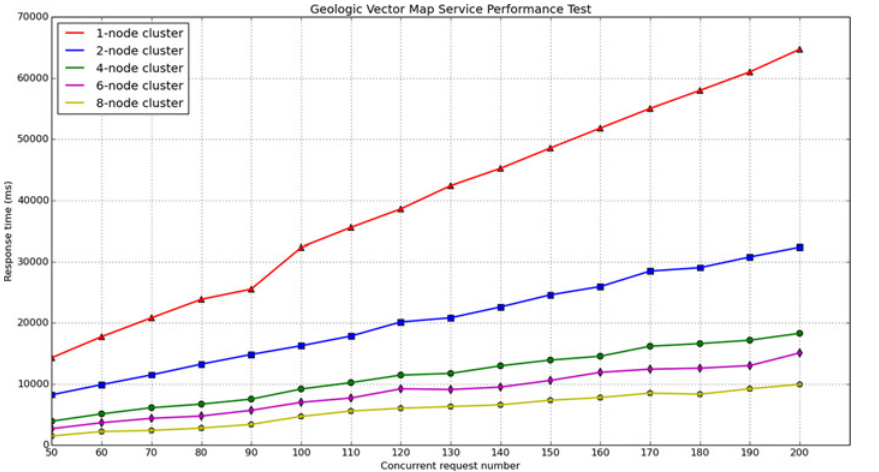
Fig 20. The geologic vector map service performance test